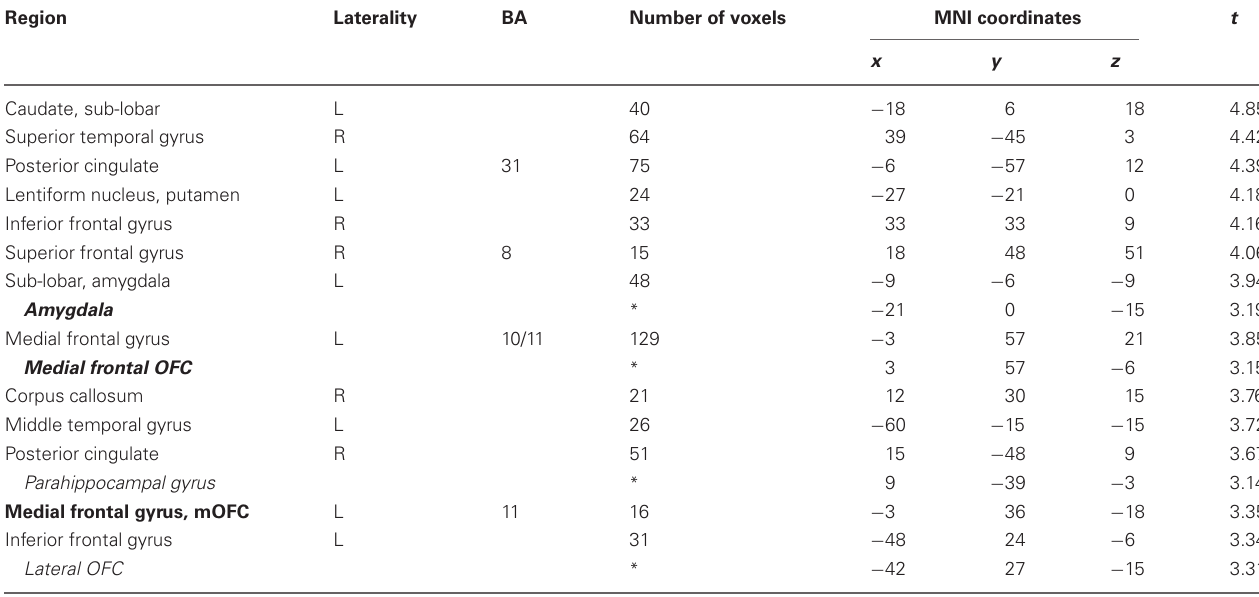
Height threshold: t ( 26 ) = 2.78, p < 0.005 (uncorrected); extent threshold, k = 15 voxels. L, left; R, right. ∗ Part of a larger